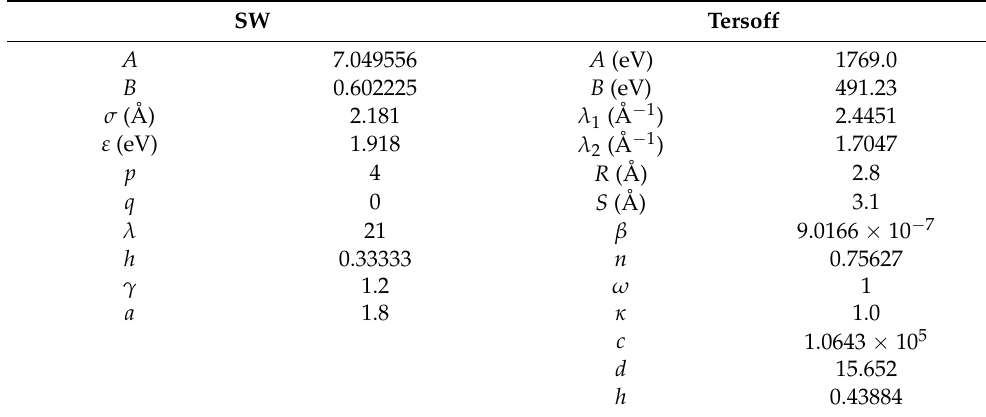
Table 1. Empirical potential